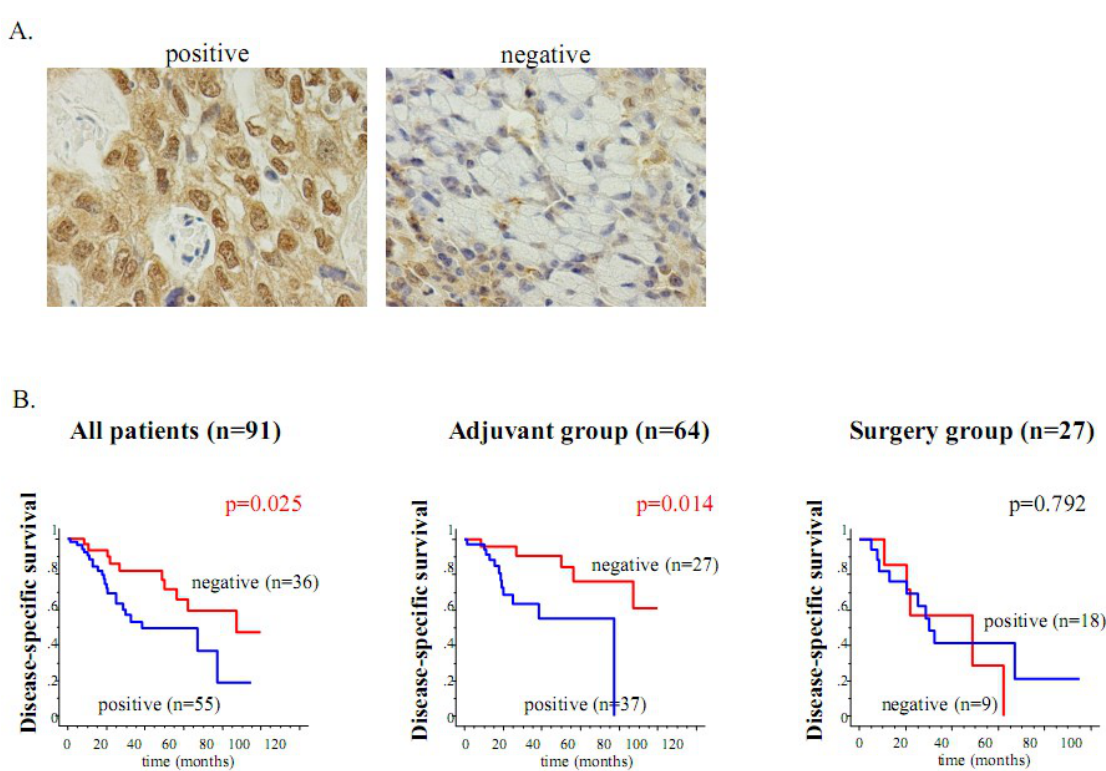
Figure 4. The HIF-1  expression is an unfavorable determinant of relapse in gastric cancer patients who undergo adjuvant 5-FU chemotherapy. ( A ) Immunohistochemical staining of HIF-1  in gastric cancer specimens. Nuclear staining of the HIF-1  expression is shown in the left panel, while the expression is negatively observed in the right panel. ( B ) Kaplan-Meier estimates of disease-specific survival (DSS) of the patients according